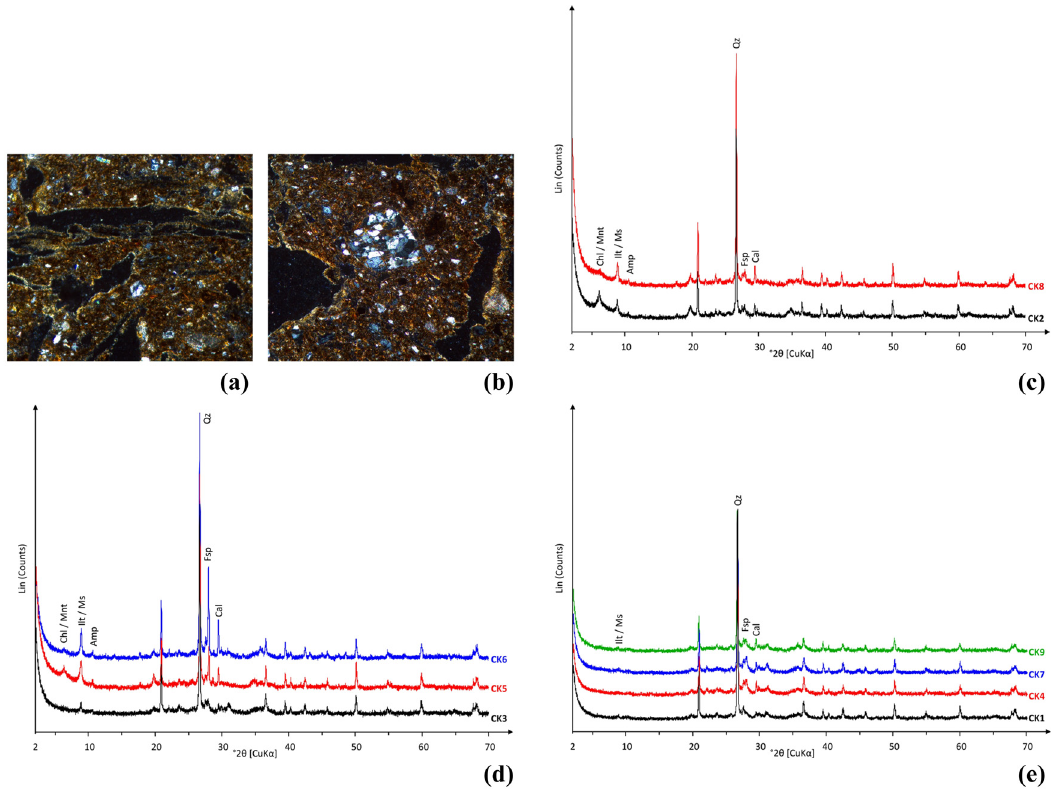
Figure 7: ( a and b ) Thin section micrographs of selected samples from the kiln structure ( fi eld of view 3mm ) . ( c ) XRPD di ff ractograms of samples C2 and C8; ( d ) XRPD di ff ractograms of samples C3, C5, and C6; and ( e ) XRPD di ff ractograms of samples C1, C4, C7, and C9. Prepared by Silvia Amicone. Mineral abbreviations from Whitney and Evans ( 2010 )